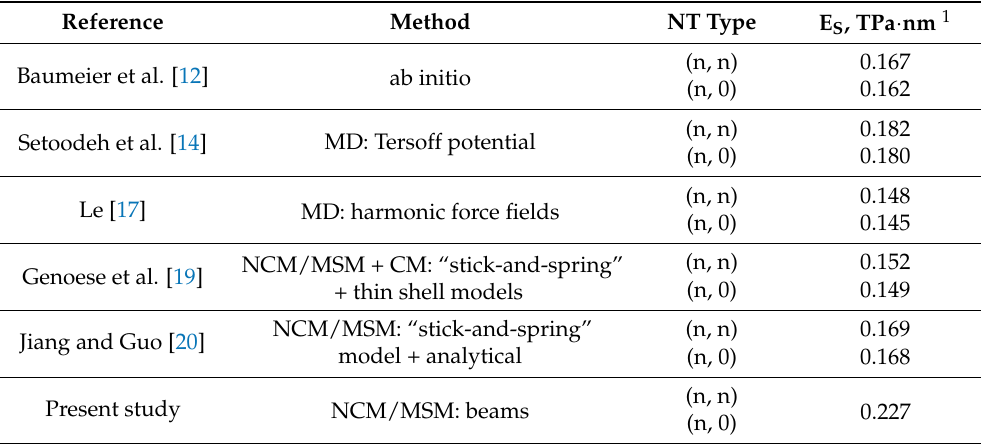
Table 3. Comparison of the surface Young’s modulus results obtained in the present study with those available in the literature.